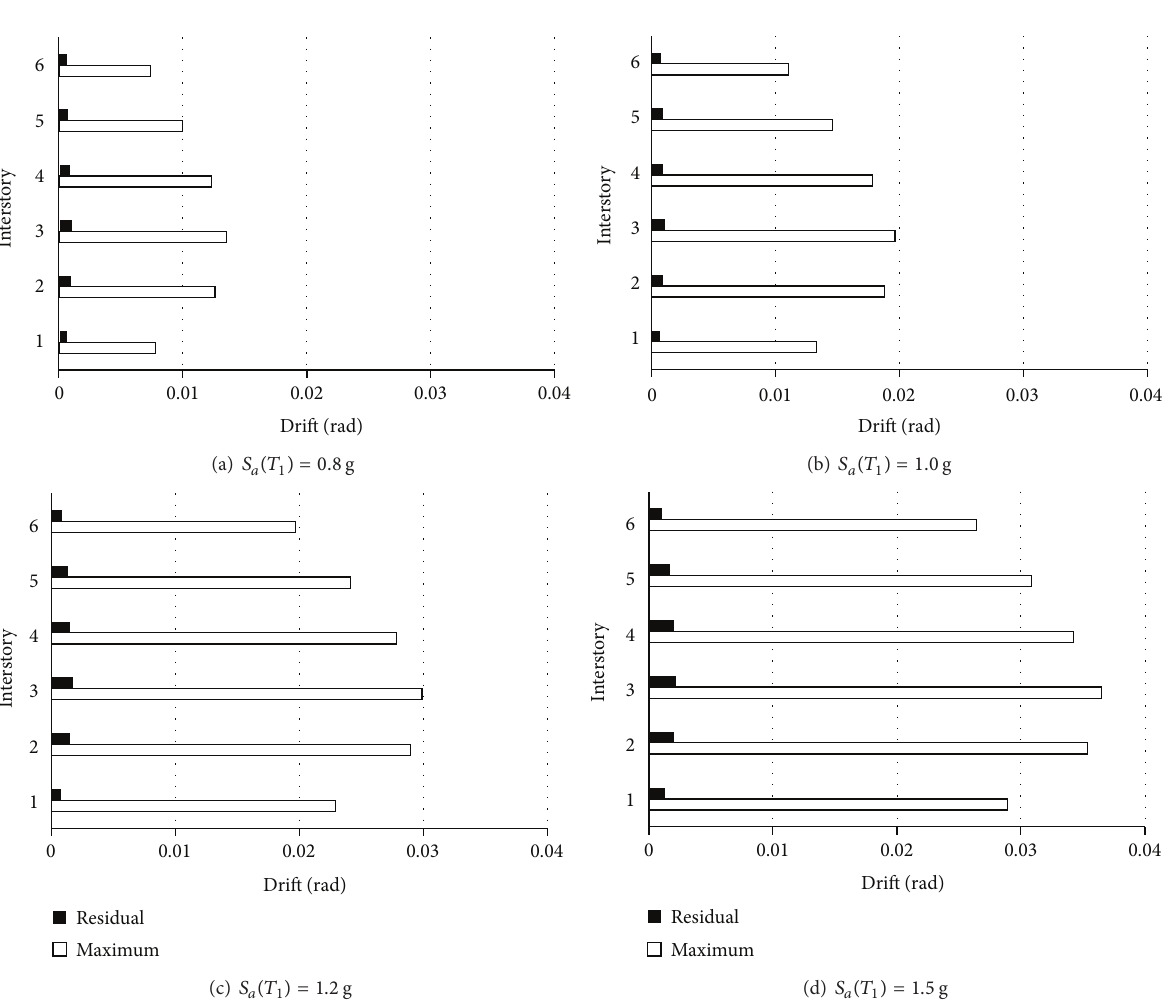
Figure 8: Median values of maximum and residual interstory drifts for F6PTC at different spectral acceleration values: (a) 0.8 g, (b) 1.0 g, (c) 1.2g, and (d)